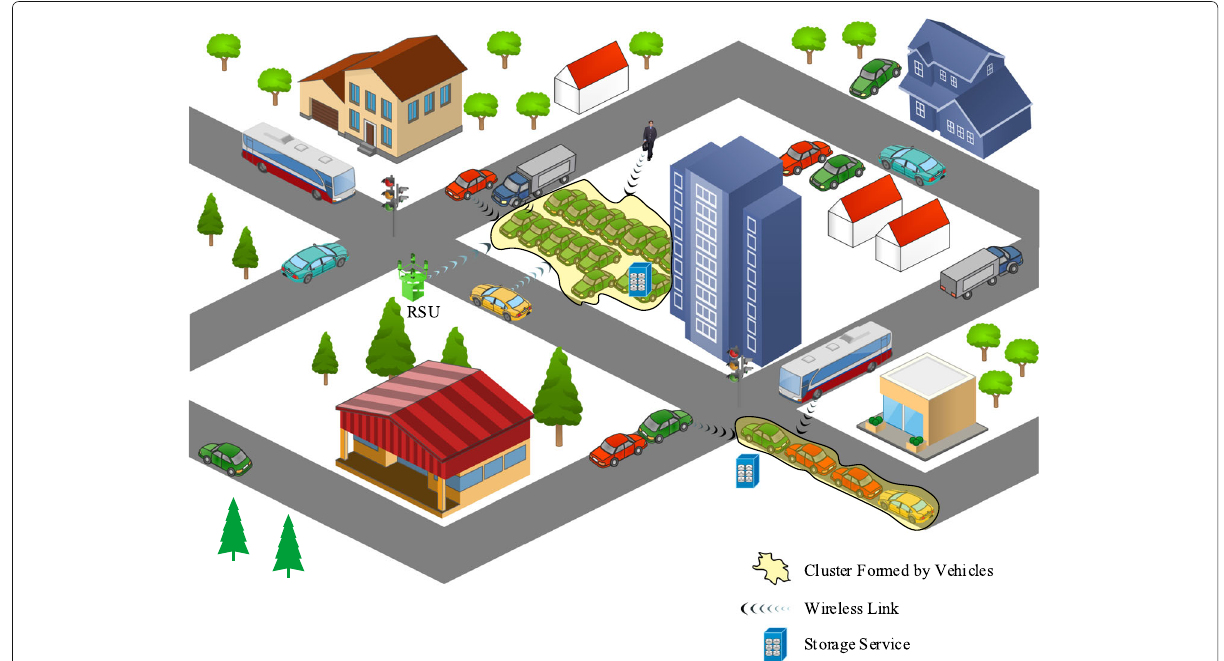
Fig. 4 VCC—Storage as a Service. Usage of vehicular network to support data storage services in off-road and on-road